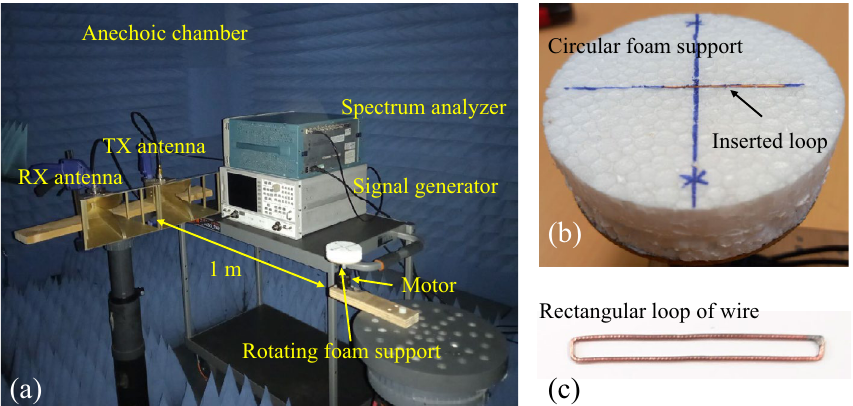
Figure 11. ( a ) The measurement bench in the anechoic chamber. ( b ) The circular foam support used for rotating the rectangular loop. ( c ) Fabricated rectangular